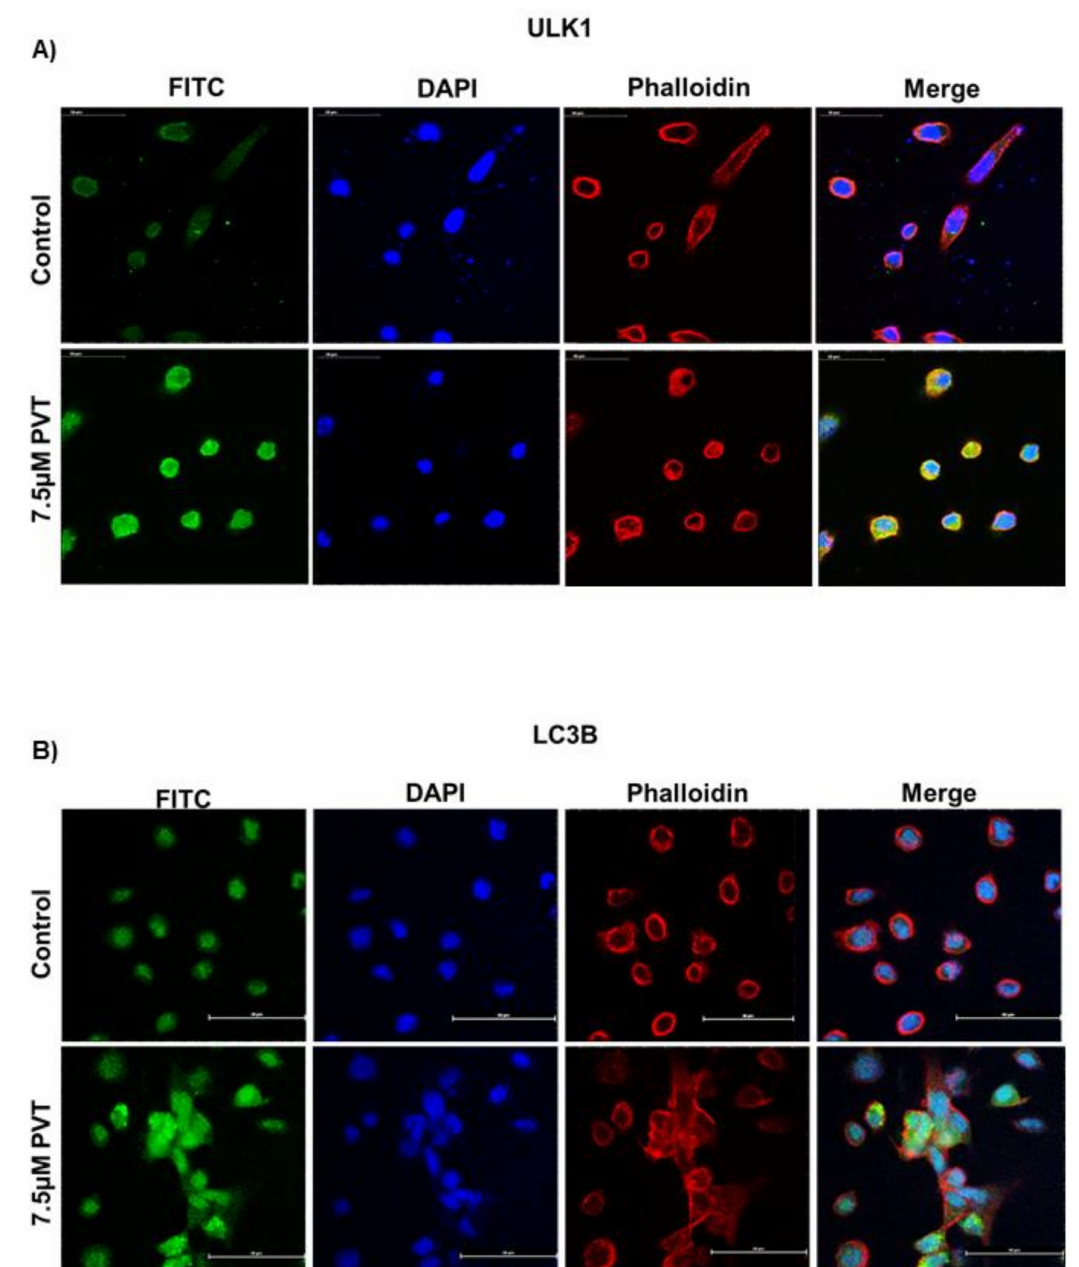
Figure 5. Confocal microscopy confirms autophagy induction in PVT treated PDAC cells. Immunofluorescence analysis of ( A ) ULK1 and ( B ) LC3B (FITC—green), Nucleus (DAPI—blue), Phalloidin (TRITC—Red) in AsPC1 cells treated with 7.5 µ M PVT for 24